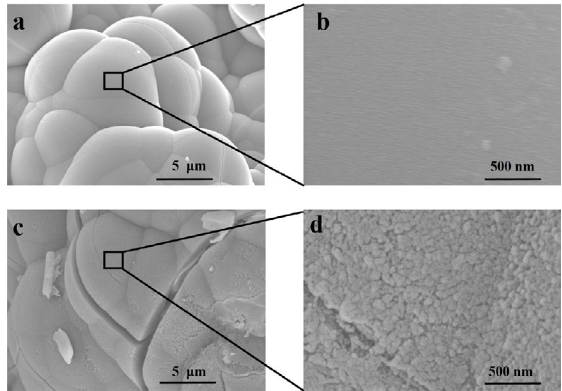
Fig. 10 Dielectric properties in 8.2–12.4 GHz of porous Si 3 N 4 –Si 3 N 4 composite ceramics (S4) before and after heat treatment: (a) the real part of permittivity, (b) the imaginary part of permittivity, and (c) dielectric